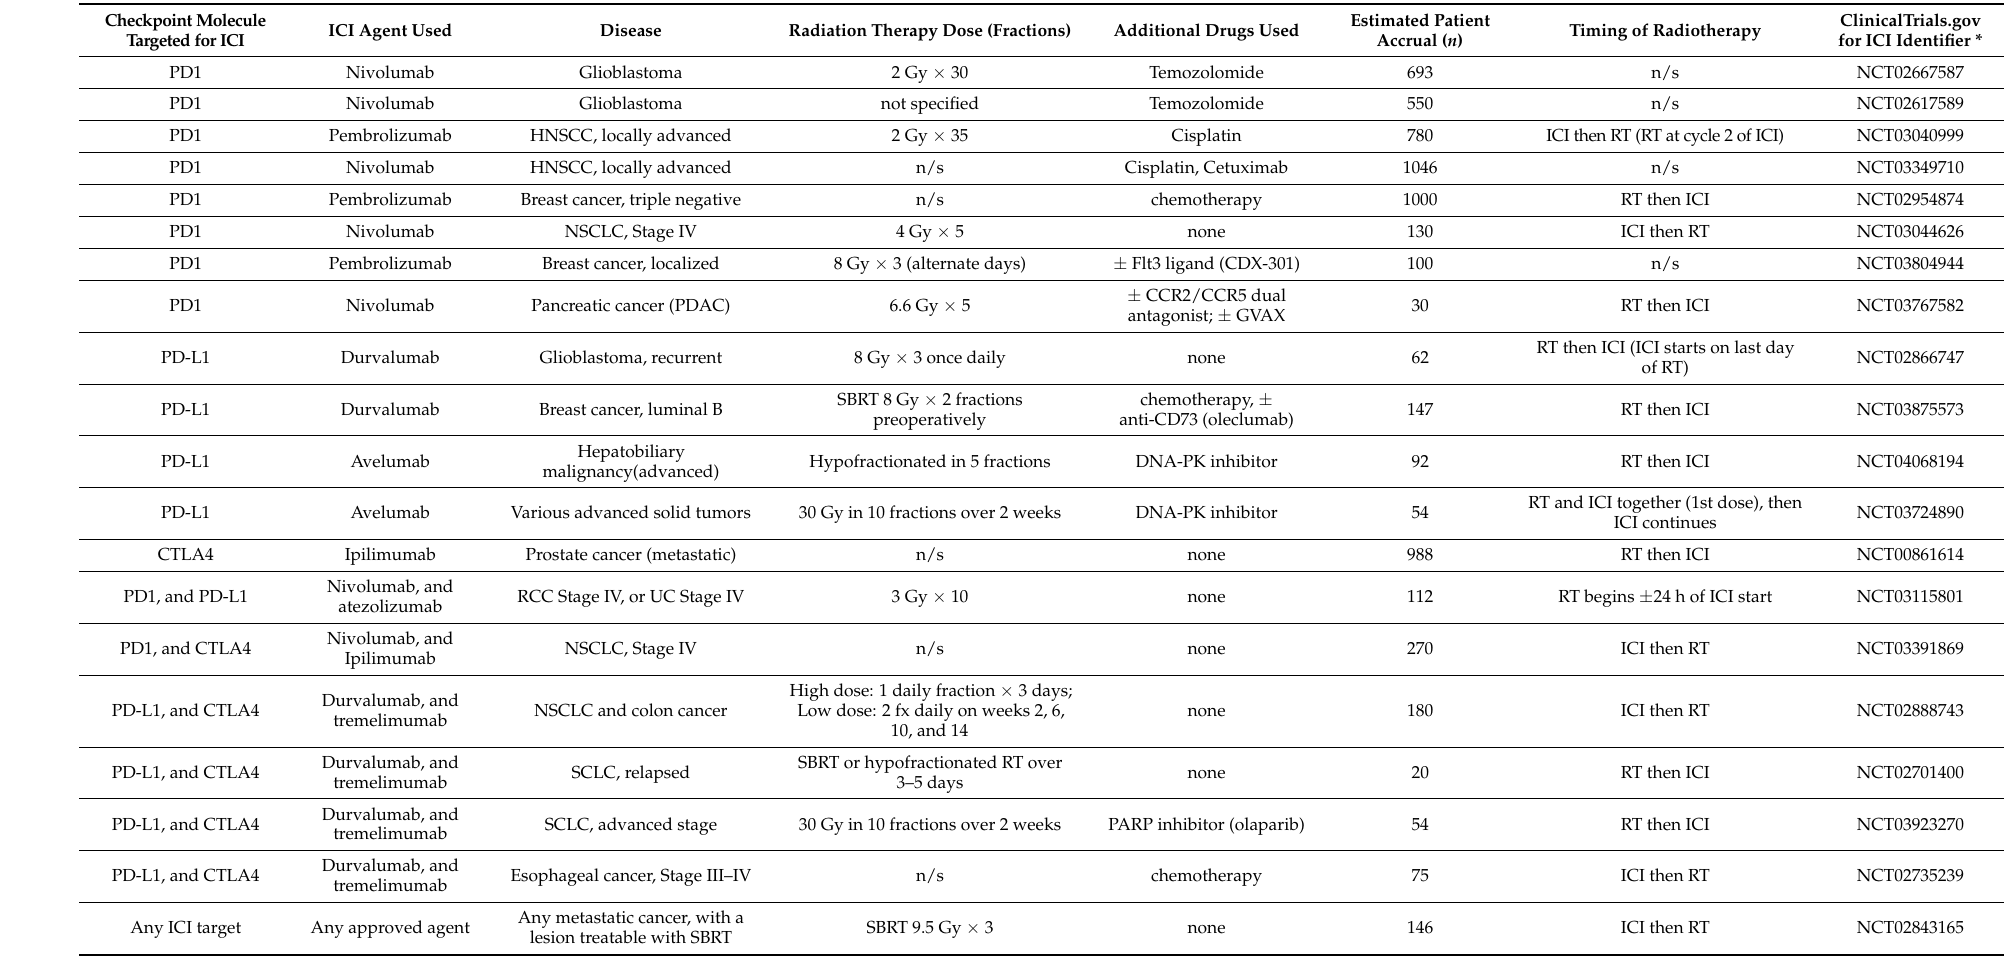
Table 4. A list of ongoing clinical studies using a combination of immune checkpoint inhibition with radiation therapy